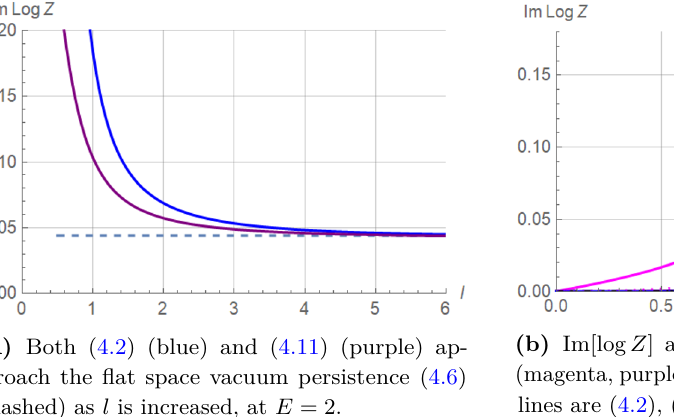
Figure 7. Both the thermal (4.2) and non-thermal (4.11) vacuum persistence have the correct flat space limit (4.6). The approach is slower in the thermal case. In both graphs, the mass m = 1 is kept fixed. E is the electric field and the de Sitter length is denoted by l